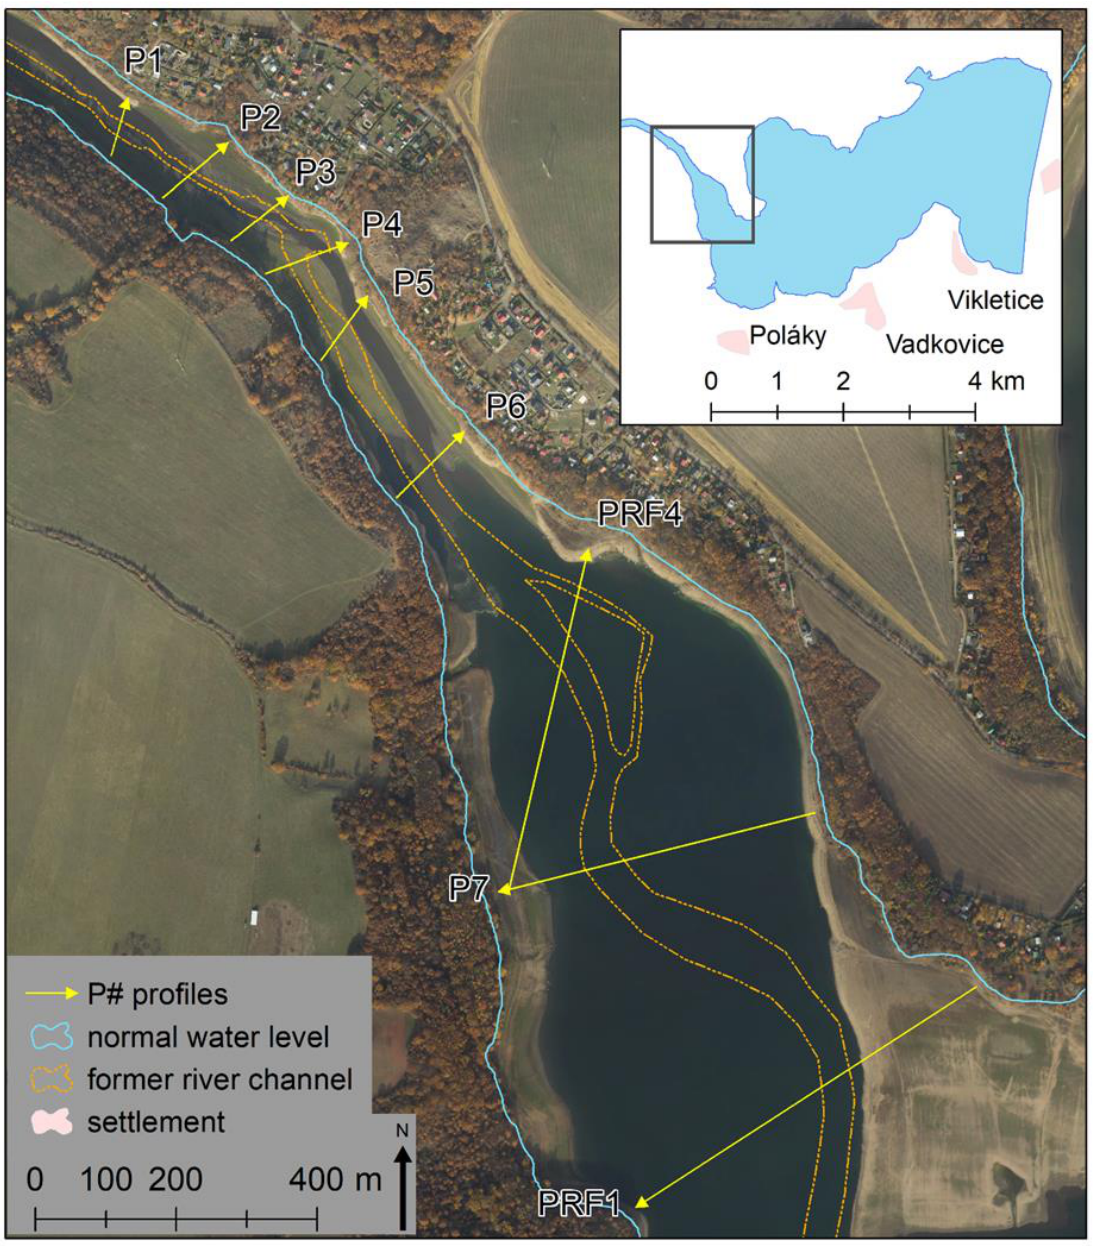
Figure 3. Detailed maps of the inflow to the Nechranice Reservoir with the positions of transect profiles (P#) for evaluation of elevation changes and profiler transects (PRF#). The orthophoto shows the 2019 drawdown.